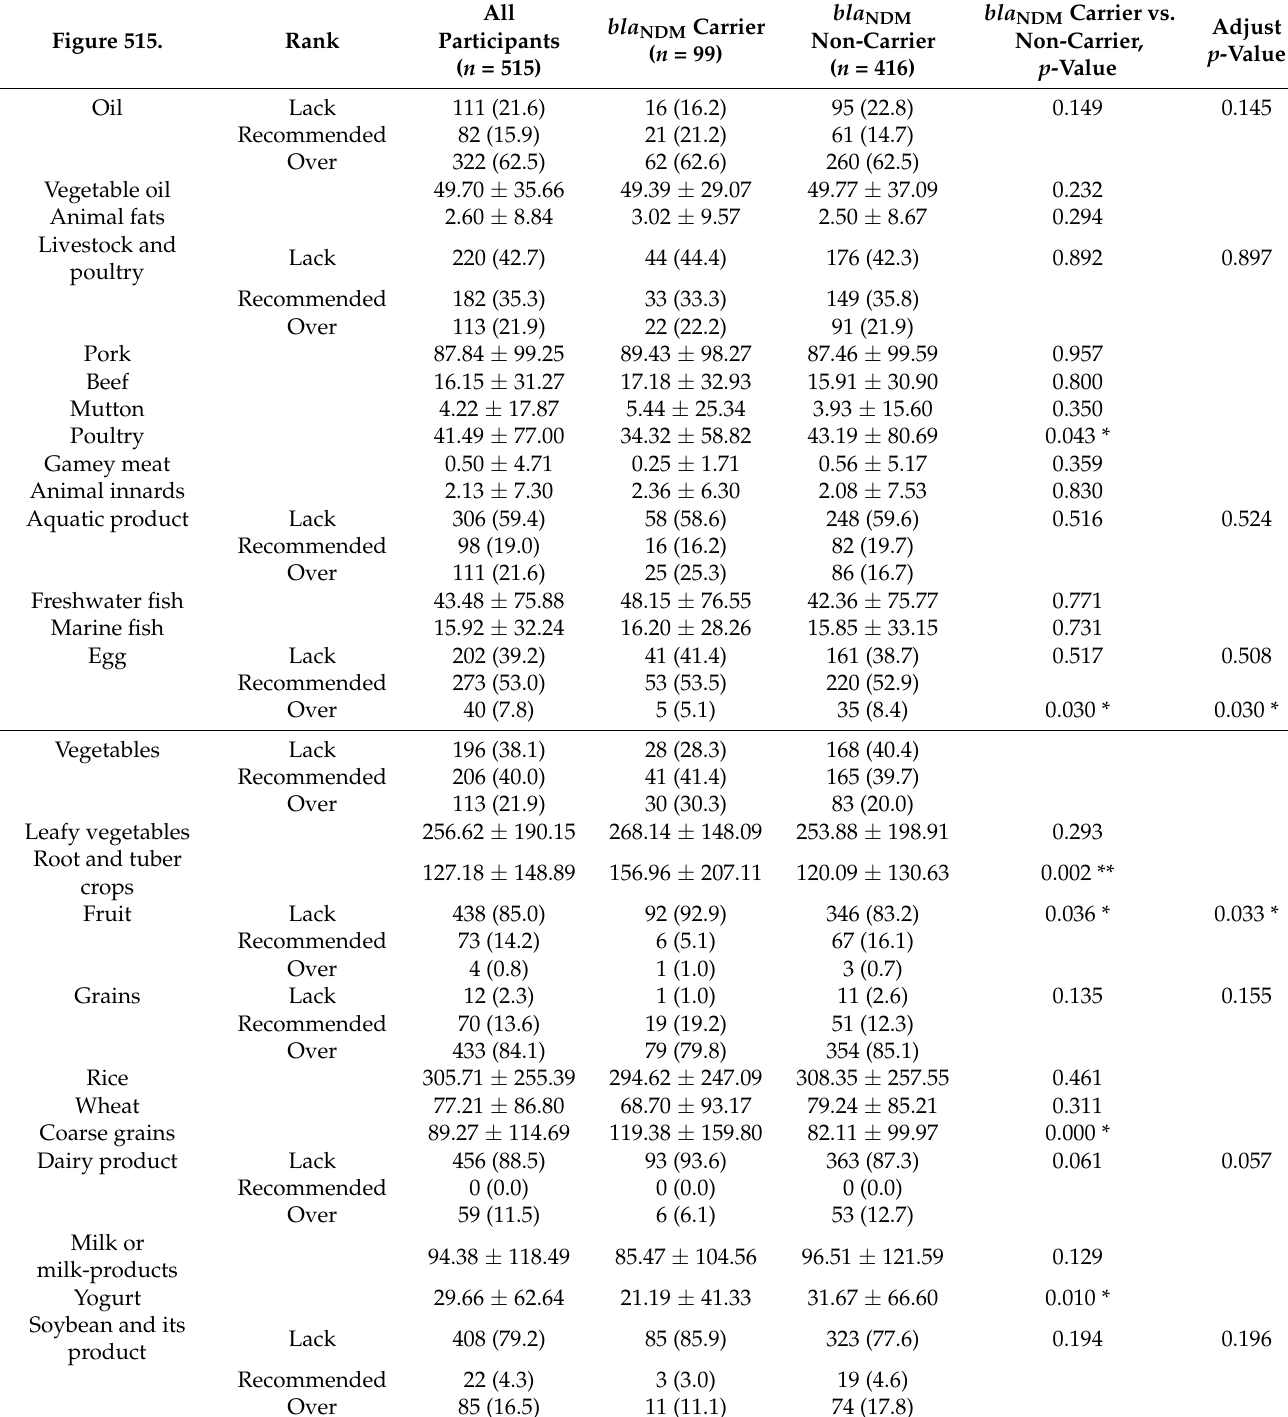
Table 2. Association between dietary intake of the participants and the carriage of bla NDM gene.